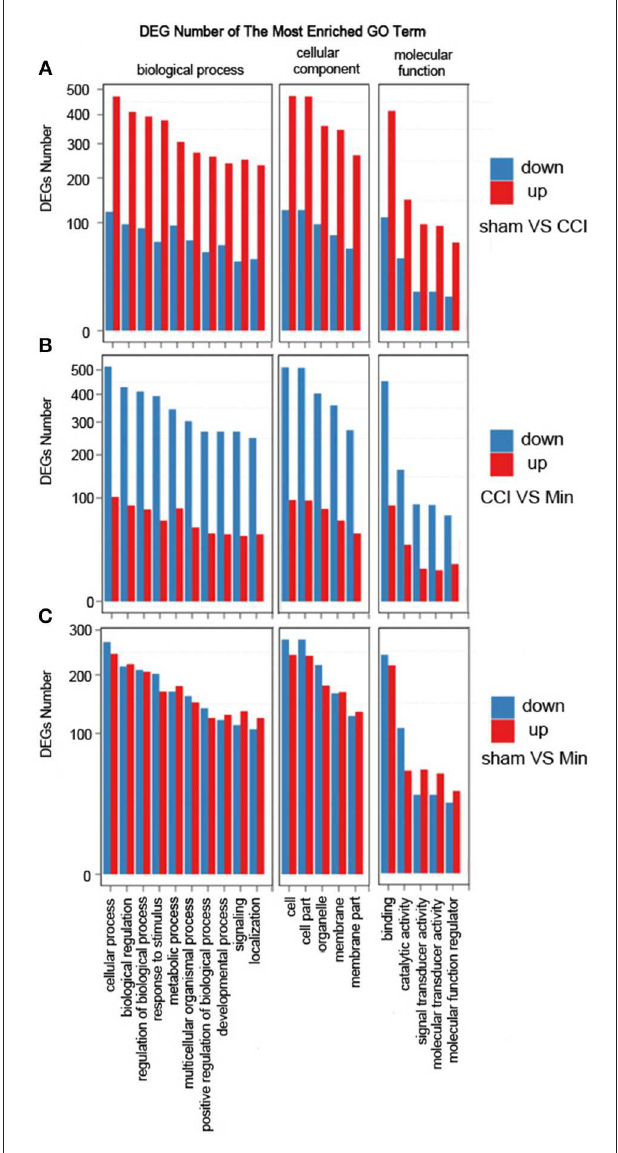
FIGURE 3 | GO term classification of increased and decreased genes on DEGs for each pairwise. X axis represents GO term. Y axis represents the number of increased/decreased genes. (A) The most enriched GO terms between the sham and CCI groups. (B) The most enriched GO terms between the CCI and minocycline-treated groups. (C) The most enriched GO terms between the sham and minocycline-treated